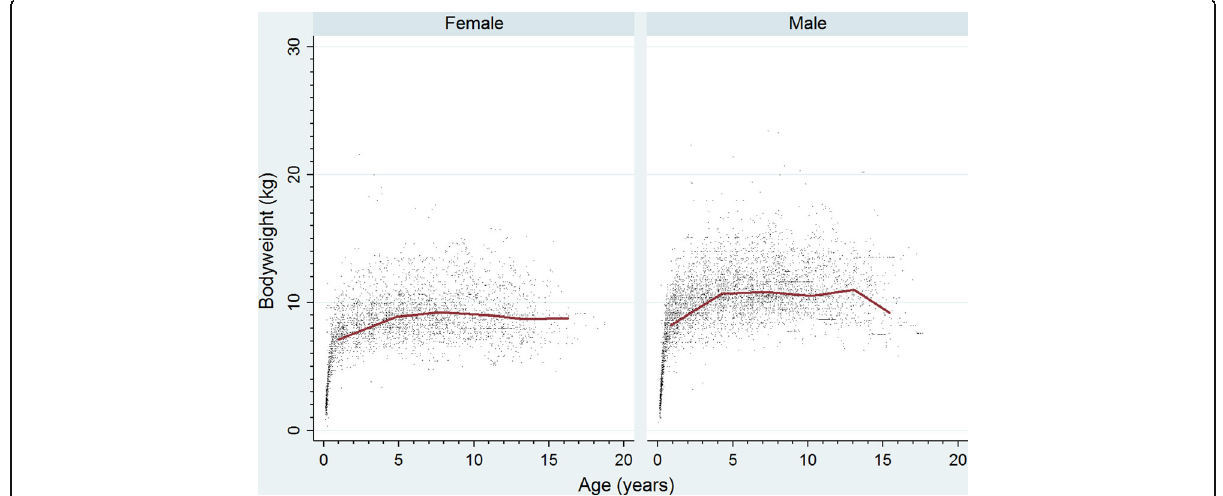
Fig. 2 Bodyweight growth curves (kg) overlaid with a cross medians line plot for 908 female and 1180 male Border Terriers under primary